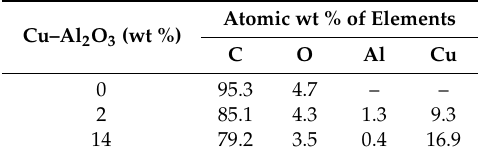
Table 2. Elemental composition of Cu–Al 2 O 3 /PS- b -(PE- r -B)- b -PS- g -MA composites. Cu–Al 2 O 3 (wt %)